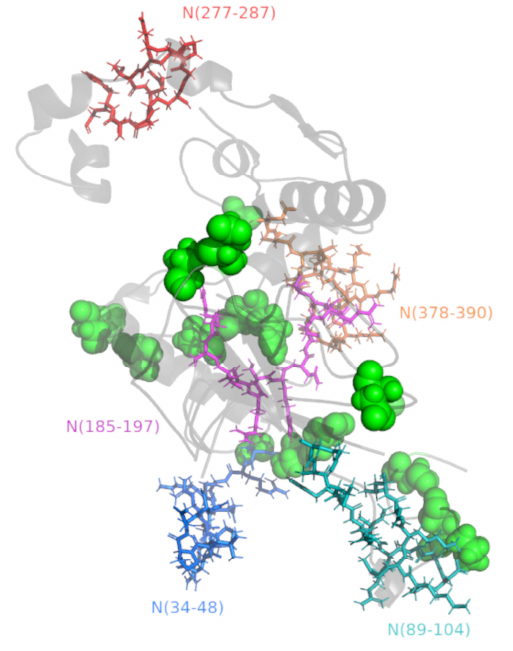
Figure 4. B-cell epitopes and key mutations in SARS-CoV-2 N protein—3D structure. The N protein was presented as cartoon (gray), in which the identified epitopes were represented by colored sticks: N (34–48) (Blue), N (89–104) (teal), N (185–197) (magenta), N (277–287) (red), and N (378–390) (orange). The positions of key mutations (D3, Q9, P13, Del31/33, D63, P80, E136, R203, G204, T205, G215, L230, S235, D377, and S413) were represented by green spheres. In the cartoon, round helices, flat sheets, and smooth loops are applied to allow better visualization of the 3D